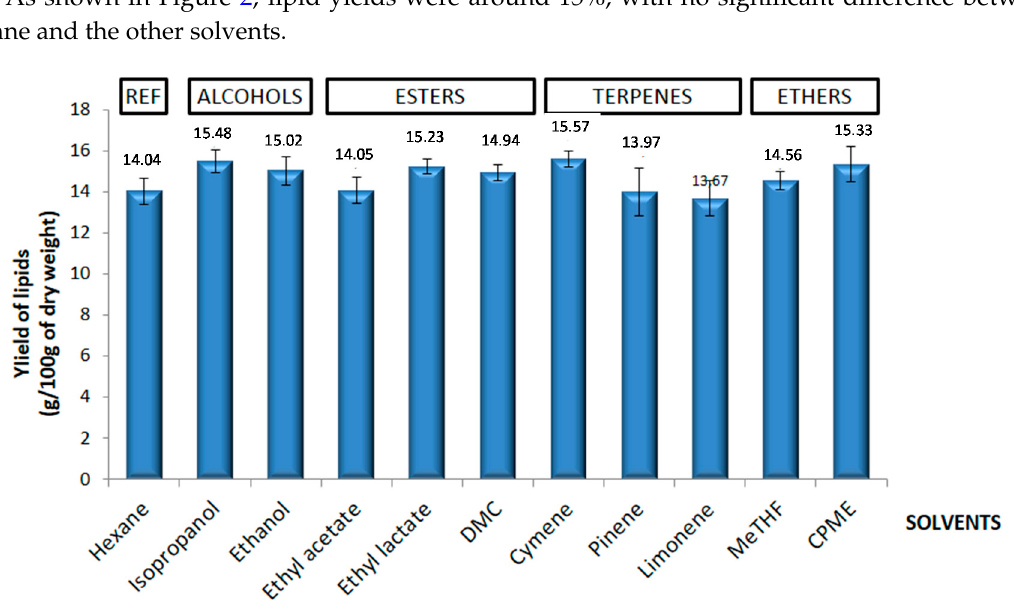
Figure 2. Comparison of yields obtained by several solvents to determinate the best solvent for the extraction of yeast